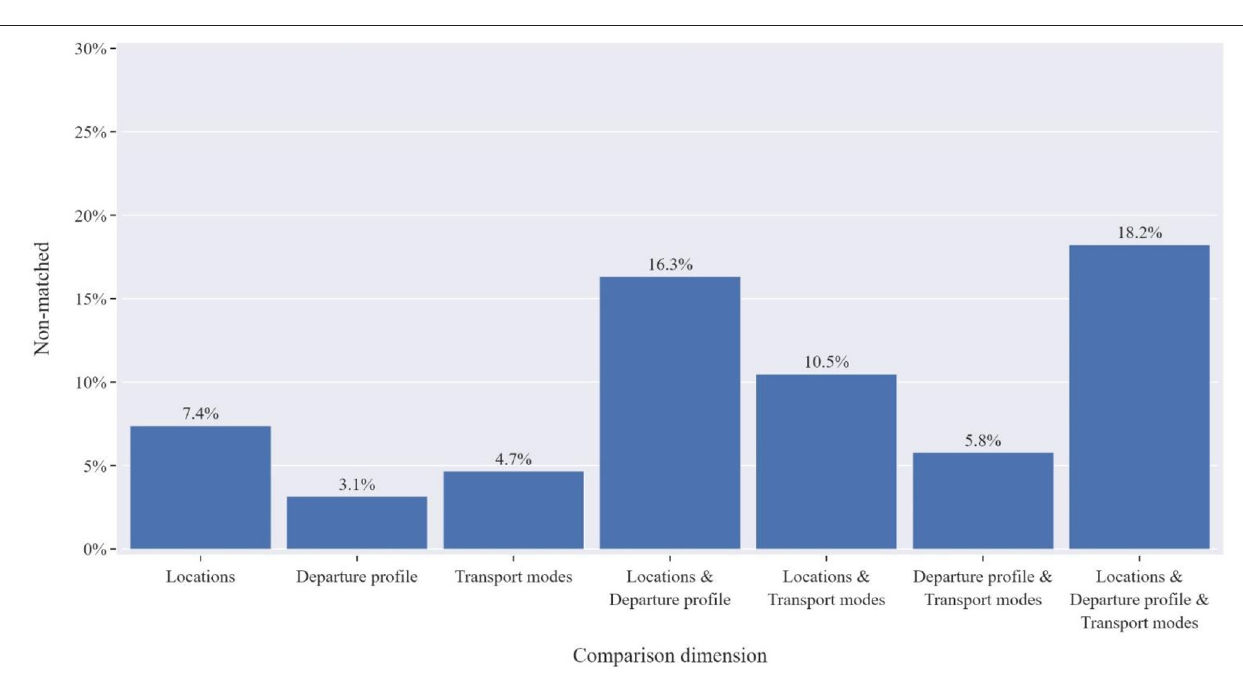
FIGURE 9 | Assessment of mismatched tours based on the defining